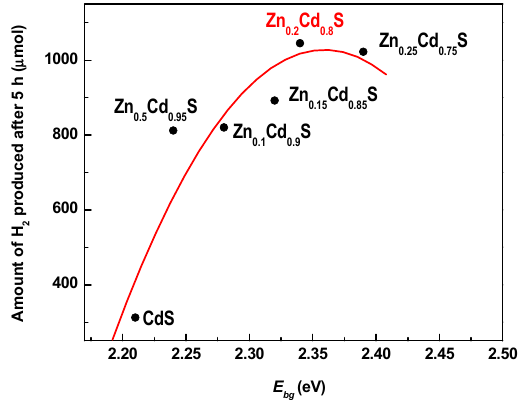
Figure 13. H 2 production during 5 h of reaction time against the energy band gap of pure CdS and Zn x Cd 1 − x S solid solutions.